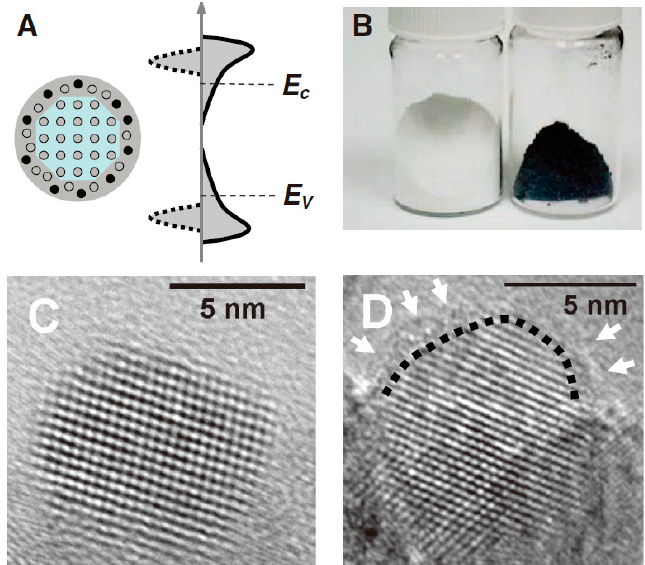
Figure 9. ( A ) Schematic illustration of the structure and electronic DOS of a semiconductor in the form of a disorder-engineered nanocrystal with dopant incorporation. ( B ) A photo comparing unmodified white and disorder-engineered black TiO 2 nanocrystals. ( C , D ) HRTEM images of TiO 2 nanocrystals before and after hydrogenation, respectively [54]. Copyright 2011 American Association for the Advancement of Science.